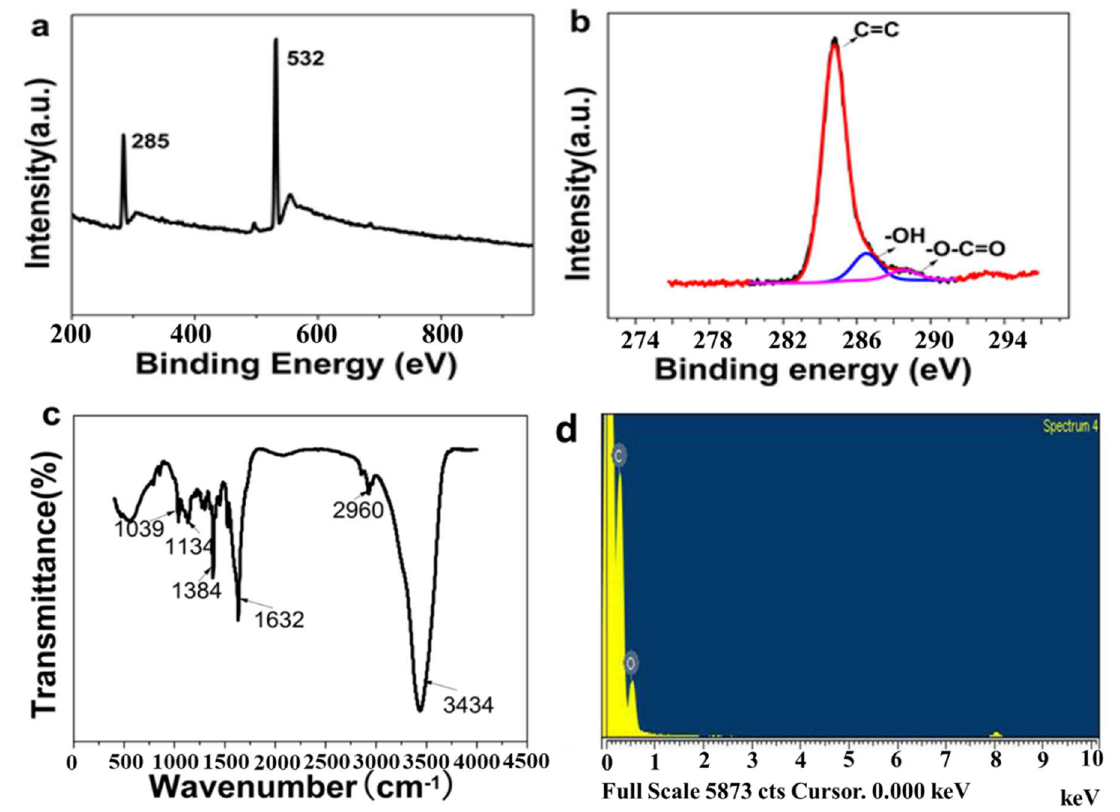
Figure 2. GQDs: ( a ) X-ray photoelectron spectroscopy (XPS) survey spectrum; ( b ) high-resolution XPS C1s spectrum; ( c ) Fourier transform infrared (FTIR) spectrum; ( d ) Energy disperse spectroscopy (EDS) spectrum.